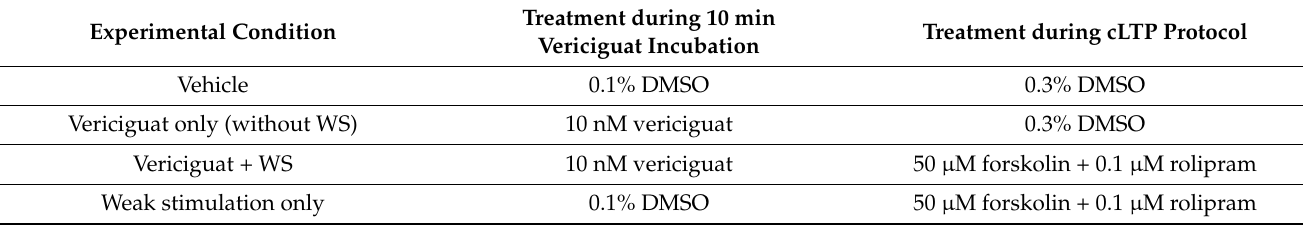
Table 2. Incubation conditions during the 10 nM vericiguat ex vivo cLTP